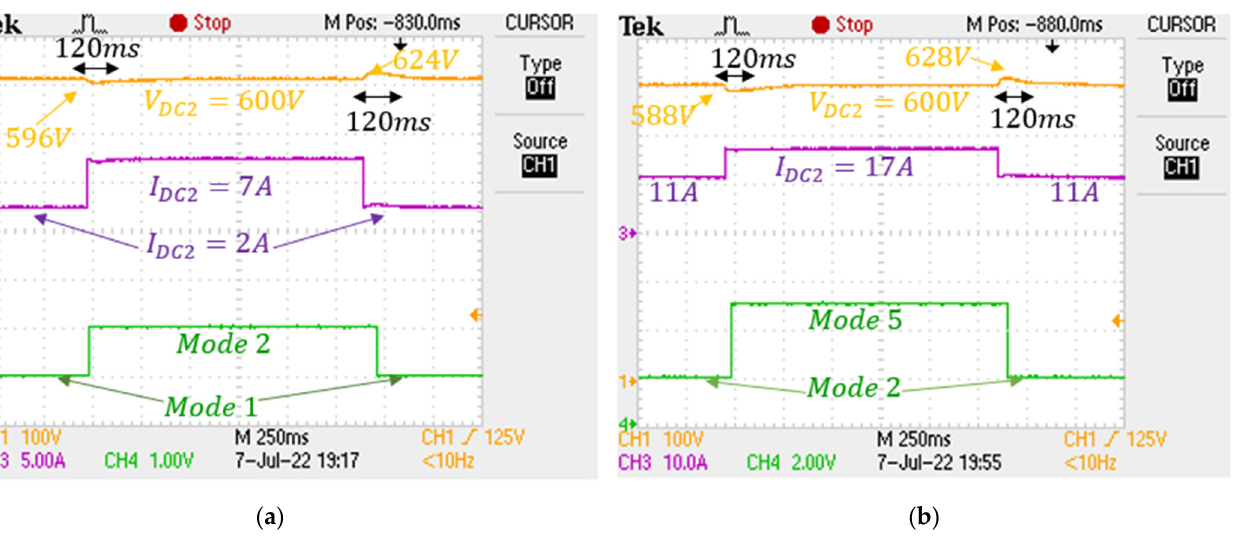
Figure 19. Transient behavior ( a ) mode 3 to mode 4, ( b ) mode 4 to mode 5.